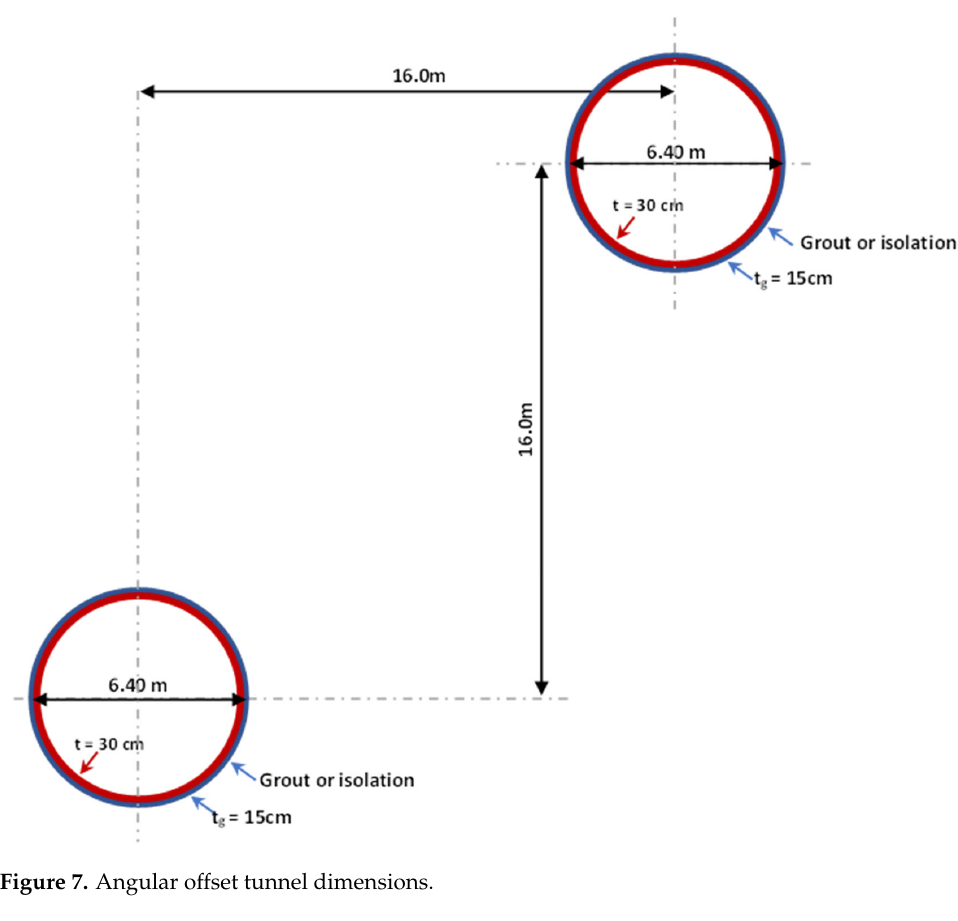
Figure 7. Angular offset tunnel dimensions.